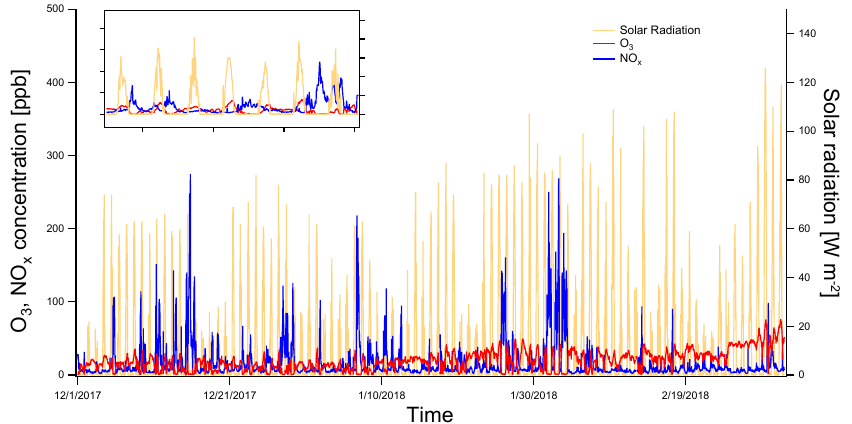
Figure 1. Time series of hourly average concentration for O 3 (red), NO x (blue) and solar radiation (yellow) during winter the period (1 December 2017–4 March 2018). The inset in the left corner emphasizes the correlations between solar radiation and O 3 and anti-correlation among solar radiation, O 3 and NO x